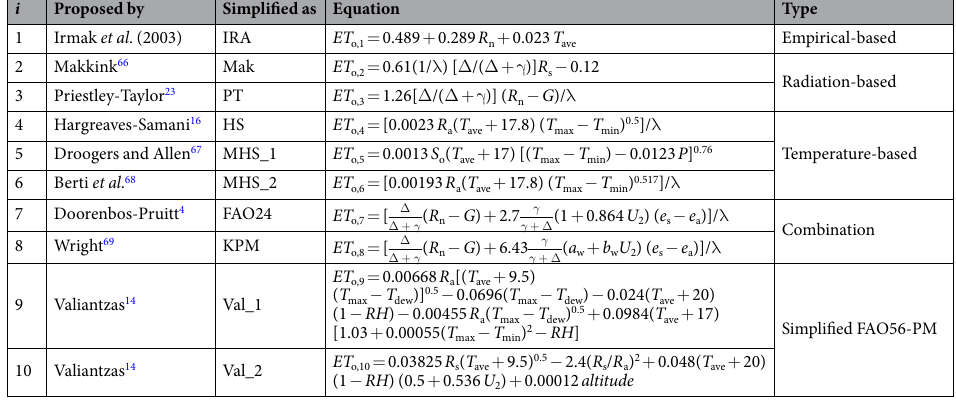
red triangle) for determination of a s and b s values at nearby sites (marked with blue circle in Fig. 1b) using the Thiessen polygon method. Estimation of ET using the other 10 selected methods. A preliminary performance comparison of o 16 ET o ( ET p ) methods were conducted (Fig. S1). From the elementary results, ET p equations performed generally worse than ET o equations. Therefore, 10 ET o equations which performed generally well in different regions of the world, i.e., Irmak et al . 65 , Makkink 66 , Priestley-Taylor 23 , Hargreaves-Samani 16 , Droogers-Allen 67 , Berti et al . 68 , Doorenbos-Pruitt 4 , Wright 69 and Valiantzas 14 , are selected to compare to the FAO56-PM equation. Of which, Valiantzas 14 proposed two equations to simplify the FAO56-PM equation. The two Valiantzas 14 equations and the Berti et al . 68 equation were relatively new, but their performances have not been validated in China. Three Hargreaves-Samani-based equations (HS, MHS_1 and MHS_2) are adopted here because the FAO-56 manual recommended HS as the use of a less demanding method with only data on T ave and extraterrestrial radiation ( R a ) 70 . The types, simplified method name, and main equations for estimating ET o of the selected 10 methods ( ET o,i , i = 1, 2, … , 10) are given in Table 1. For the Droogers and Allen 67 method (simplified as MHS_1), ϕ δ + S w 15 392 ( sin( )sin( ) cos( )cos( )sin( )) . For the Berti et al . 68 method (simplified as MHS_2), P is o r s s precipitation. For the Valiantzas 14 method (simplified as Val_1), T dew = [116.91 + 237.3 ln(e a )]/[16.78- ln (e a )]. For  the Wright 69 method (simplified as KPM), a w = 0.3 + 0.58 exp  − where J is Julian day in the year between 1 (1 January) and 365 or 366 (31 December). Performance evaluation of the 10 selected methods. Relative error ( RE ), standard deviation ( θ ) and Nash-Sutcliffe efficacy coefficient ( NSE ) 71 are used to assess the performances of monthly ET o,i : − = RE